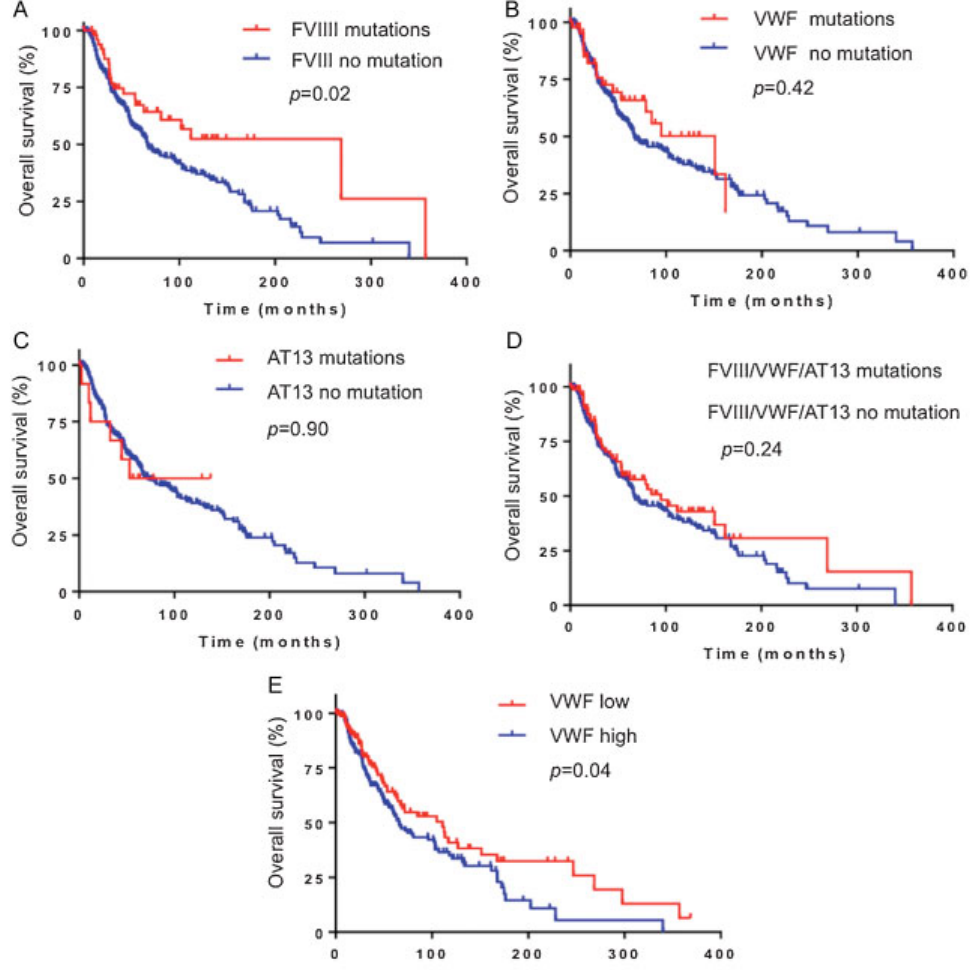
Fig. 4 Association of mutations in FVIII , VWF , and ADAMTS13 and their expression levels with the long-term outcomes of cutaneous melanoma. ( A ) FVIII mutations are associated with a better overall survival rate ( p ¼ 0.02). ( B and C ) VWF and ADAMTS13 (AT13) mutations are not associated with a better overall survival rate ( p ¼ 0.42 and p ¼ 0.90, respectively). ( D ) Combined mutations of VWF / FVIII / AT13 are not associated with an overall survival rate ( p ¼ 0.24). ( E ) Low VWF mRNA expression is associated with a better survival rate ( p ¼